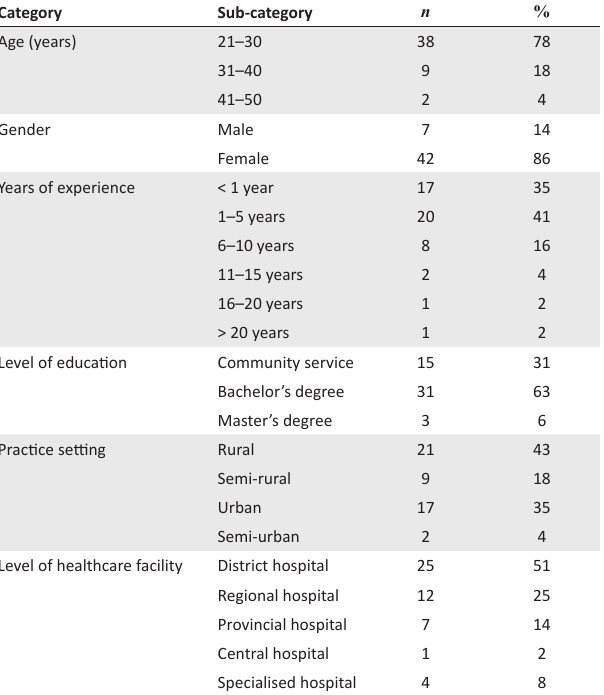
TABLE 1: Demographic information ( n = 49).